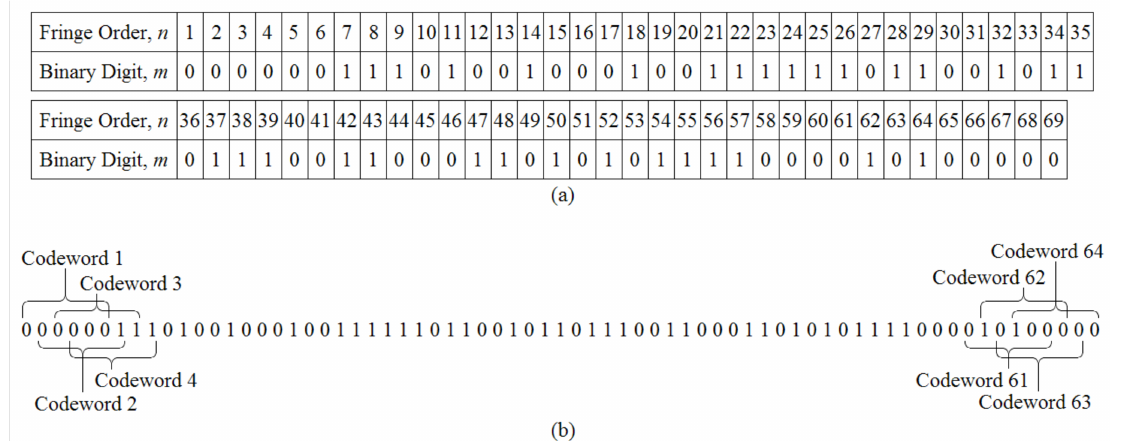
Figure 2. ( a ) A list of the fringe order n with the corresponding binary digit m . ( b ) An illustration depicting that the stream of binary digits was formed by assembling 64